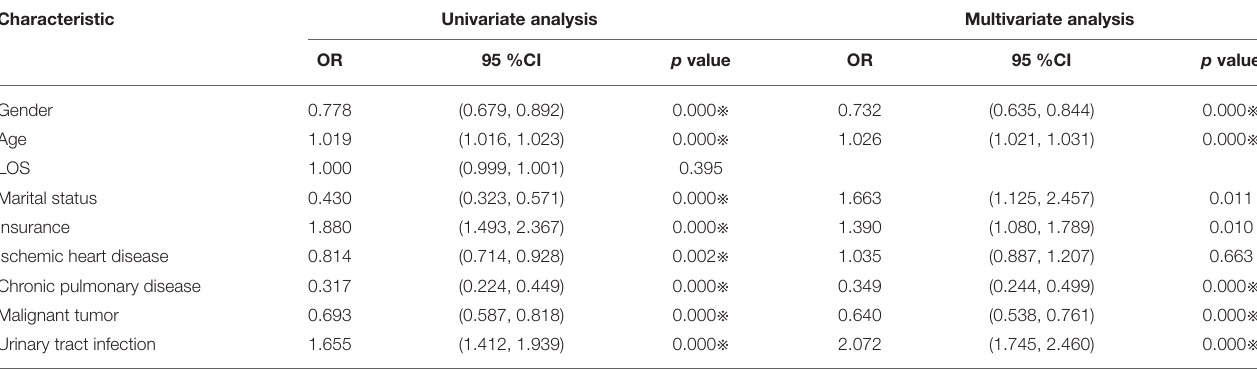
TABLE 5 | Logistics regression on the indicators of in-hospital